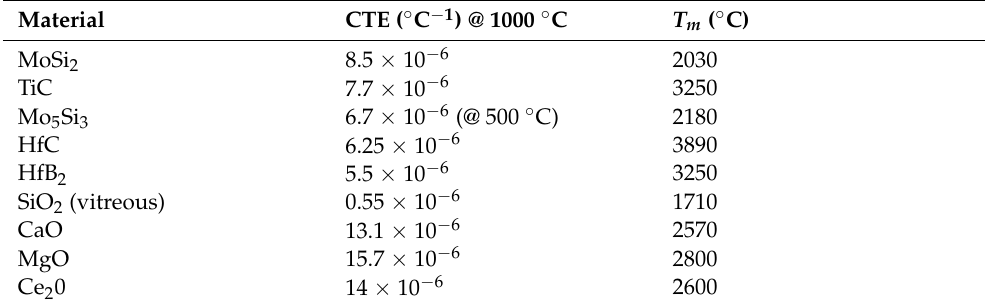
Table 7. Coefficients of thermal expansion (CTE) and melting temperatures T m for MoSi 2 and several potential particulate additions